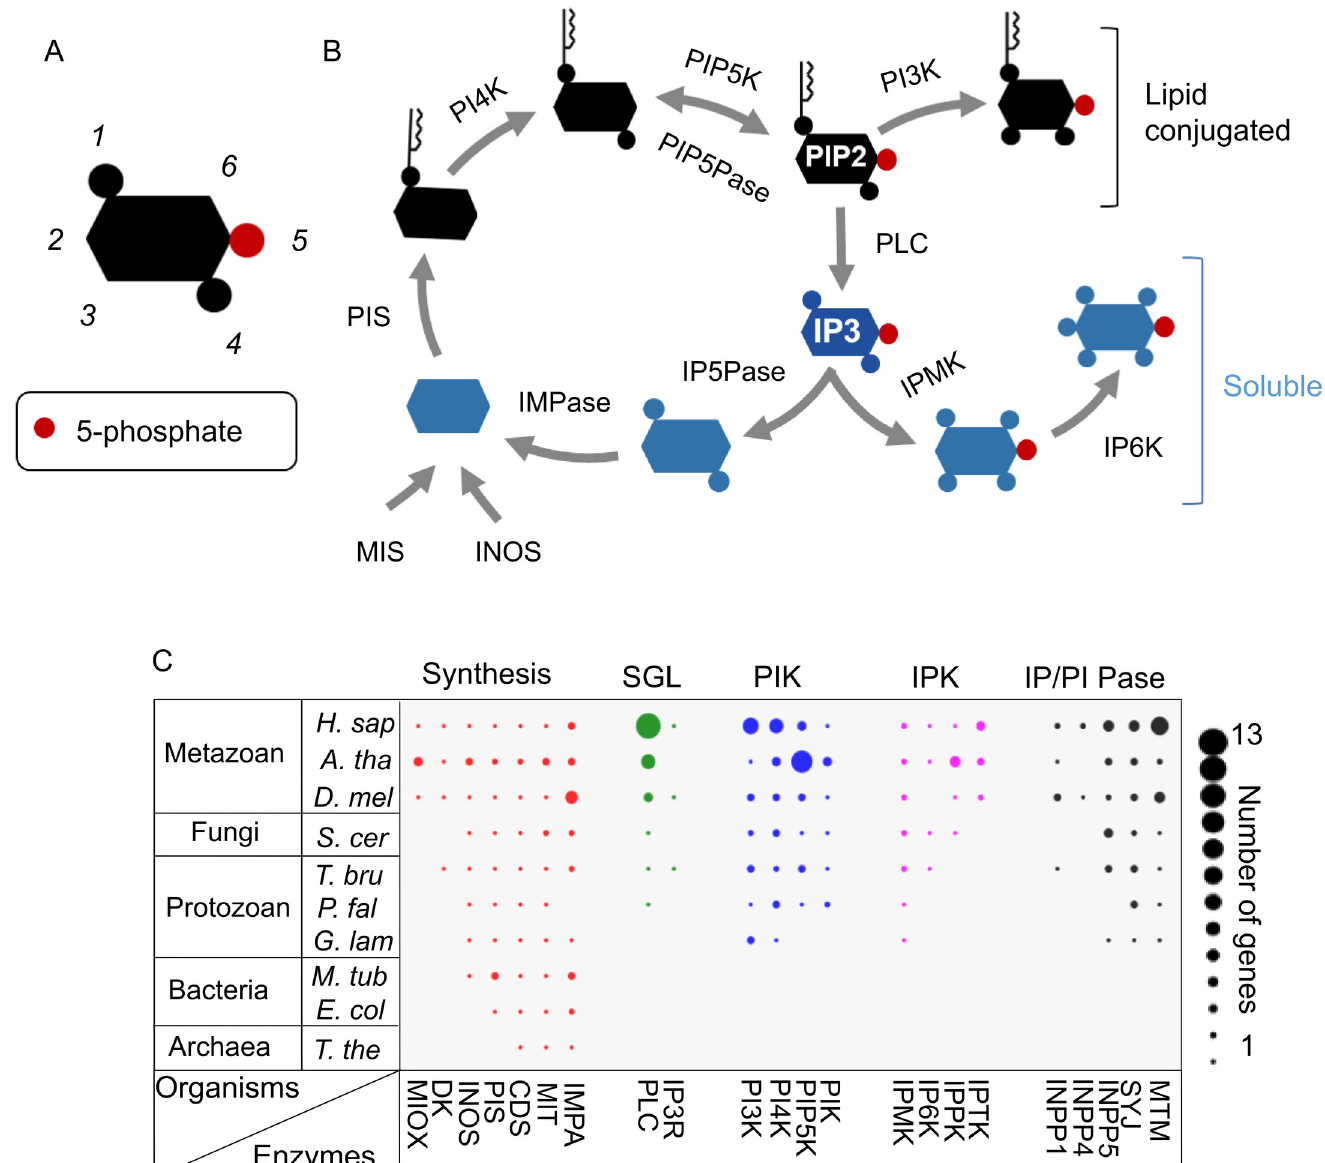
Fig 2. Overview of the PI system in T . brucei . (A) Diagram showing numbering of inositol positions that can be phosphorylated, dephosphorylated, or pyrophosphorylated. Positions 1, 4, and 5 are phosphorylated in IP3 (position 5 is shown in red) and is shown as an example. (B) Simplified diagram showing lipid conjugated (in black) and soluble (in blue) metabolites and enzyme activities for the metabolite interconversions. See Table 1 for the list of the enzymes (and their abbreviations) found in T . brucei . PLC cleavage releases IP3 from the lipid. Inositol can be synthesized from glucose-6-phosphate by INOS or transported as MIS, and PI is synthesized by PIS. (C) PI gene homologs in prokaryotes, protozoa, fungi, and metazoa. The numbers of homologous PI genes are indicated by the circle sizes in each organism. The general roles of the enzymes in synthesis, SGL, PI, or IP kinase (PIK or IPK) and IP or PI phosphatase (IP/PI Pase) are labeled and represented by different colors. IP/PI Pase indicate enzymes that can dephosphorylate IPs and/or PIs. The organisms are Homo sapiens (H . sap) , Arabidopsis thaliana (A . tha) , Drosophila melanogaster (D . mel) , Saccharomyces cerevisiae (S . cer) , T . brucei (T . bru) , Plasmodium falciparum (P . fal) , Giardia lamblia (G . lam) , Mycobacterium tuberculosis (M . tub) , Escherichia coli (E . col) , and Thermus thermophilus (T . the) . CDS, CDP-diacylglycerol synthetase; DK, diacylglycerol kinase; IMPA, Inositol- 1-monophosphatase; IMPase, inositol (1,4) monophosphatase; INOS, inositol-3-phosphate synthase; INPP1, inositol polyphosphate-1-phosphatase; INPP4, inositol polyphosphate-4-phosphatase; INPP5, inositol polyphosphate-5-phosphatase; IP, inositol phosphate; IPK, inositol polyphosphate kinase; IPMK, inositol polyphosphate multikinase; IPPK, inositol-pentakisphosphate 2-kinase; IPTK, inositol trisphosphate 5/6 kinase; IP3, inositol trisphosphate; IP3R, inositol 1,4,5-triphosphate receptor; IP5Pase, inositol polyphosphate 5-phosphatase; IP6K, inositol hexakisphosphate kinase; MIOX, myo-inositol oxygenase; MIS, myo- inositol-1-phosphate synthase; MIT, myo-inositol/proton symporter; MTM, phosphatidylinositol-3-phosphatase myotubularin; PI, phosphatidylinositol; PIK, phosphatidylinositol kinases; PIP2, phosphatidylinositol 4,5-bisphosphate; PIP5K, phosphatidylinositol 4-phosphate 5-kinase; PIP5Pase, phosphatidylinositol 5-phosphatase; PIS, phosphatidylinositol synthase; PI3K, phosphatidylinositol 3-kinase; PI4K, phosphatidylinositol 4-kinase; PLC, phospholipase C; SGL, signaling; SYJ, phosphatidylinositol 5-phosphatase synaptojanin.